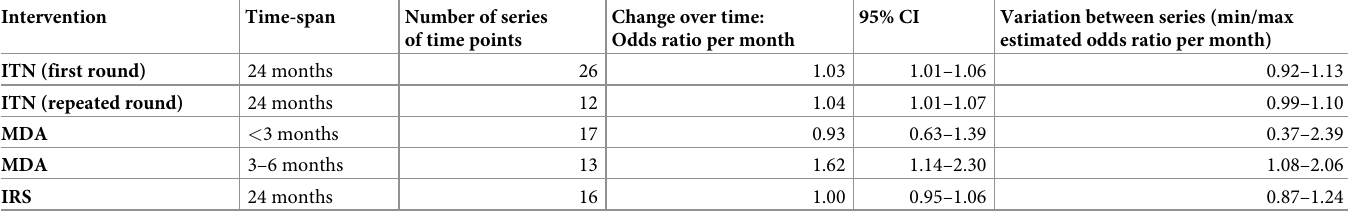
Table 4. Estimated changes in the proportion of clinical cases that were P. vivax over time for each intervention separately, adjusted for season at time-point of survey. Intervention